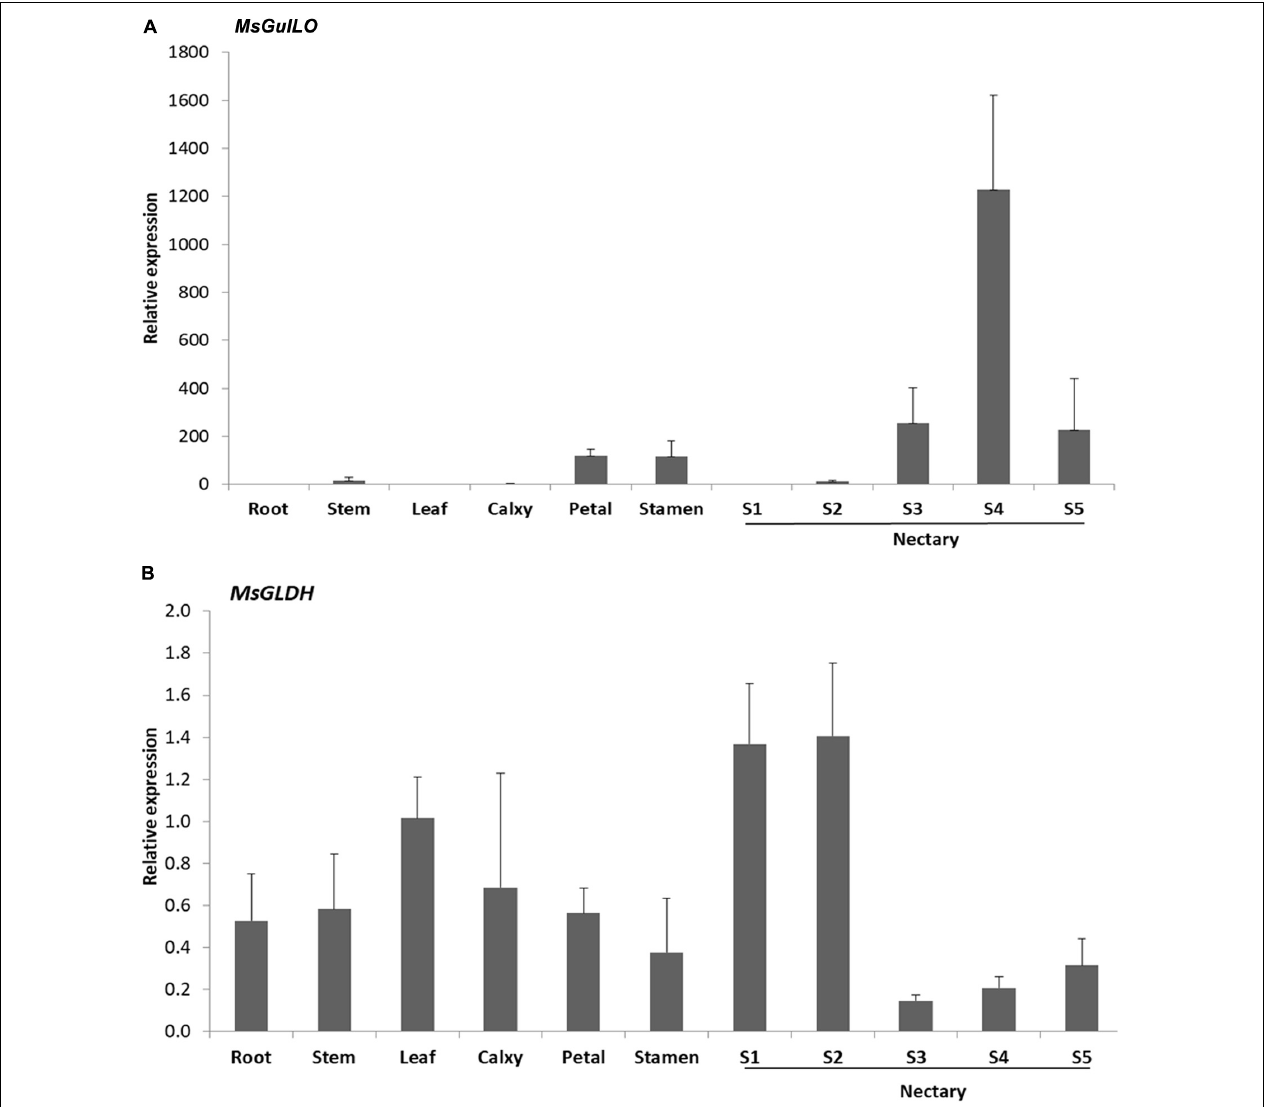
FIGURE 4 | Determination by qRT-PCR of transcript levels of MsGulLO and MsGLDH in various tissues. (A) MsGulLO expression patterns. (B) MsGLDH expression patterns. Whole RNA was isolated from the following tissues: stems, roots, petals, calyxes, stamens, leaves; S1–S5, nectaries at developmental stage 1–5. All data were normalized to 18S rRNA transcript levels. Values represent mean ± SE from three biological